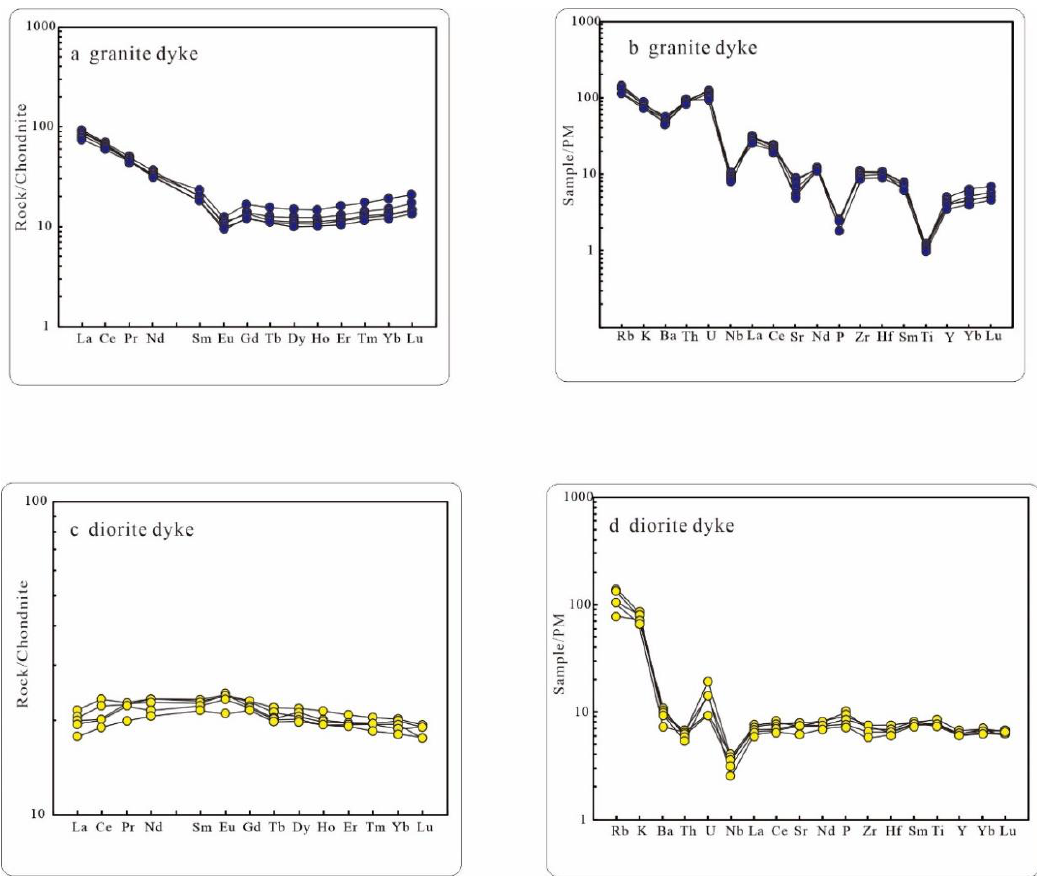
Figure 8. Plots of chondrite-normalized REE patterns and plots of primitive mantle-normalized trace element patterns for the granite and diorite dykes in the Jinba deposit (primitive mantle-normalized values and chondrite-normalized values are from Boynton [43] (1984) and Sun et al. [44] (1989)).